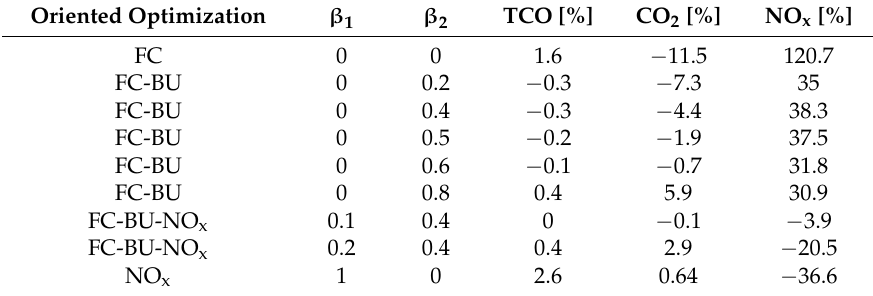
Table 13. Increment in TCO, CO 2 and NO x emissions for different objective functions over the 1015 mission, with respect to the default J function, for the compact vehicle with no